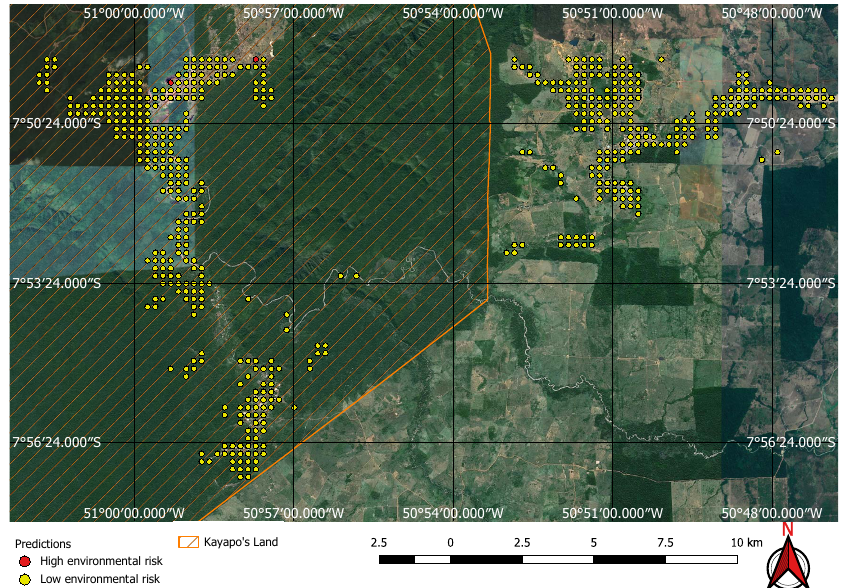
Figure 16. Mines identified on the Kayapo’s protected land.